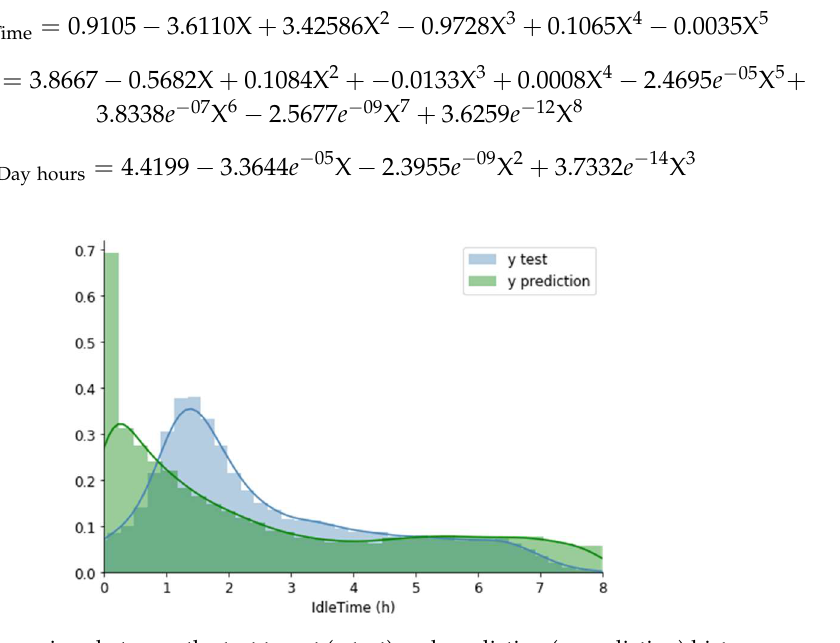
Figure 7. Comparison between the test target (y test) and prediction (y prediction) histograms.